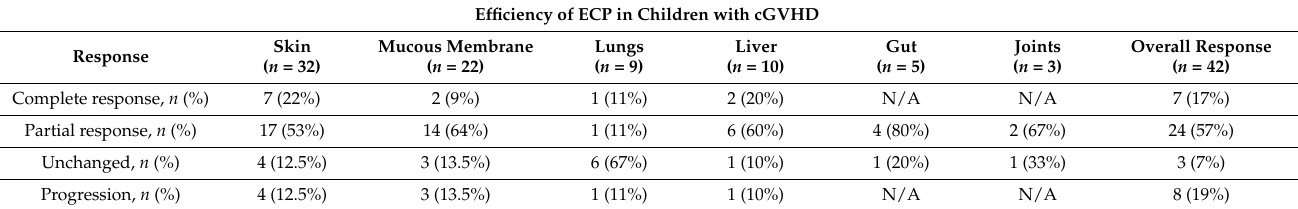
Table 2. Clinical response to extracorporeal photophersis in children with cGVHD.